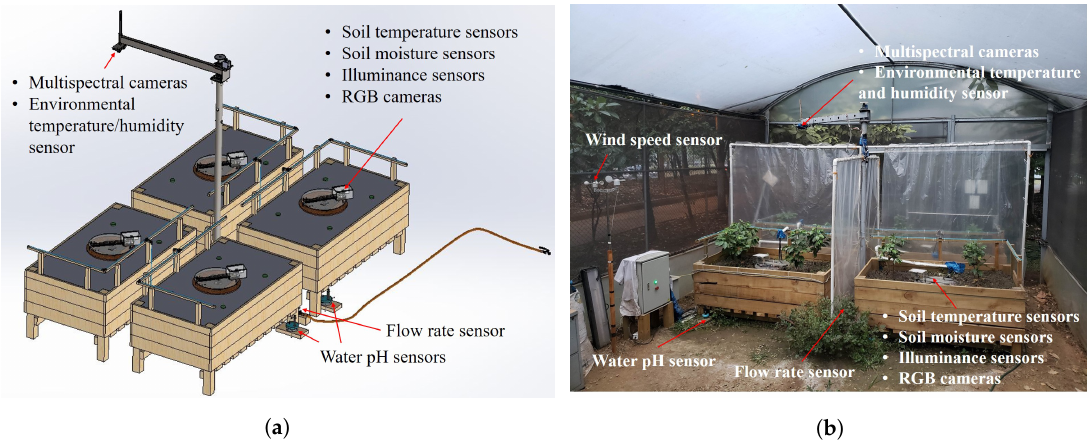
Figure 7. Experimental testbed: ( a ) 3D CAD model; ( b ) implemented prototype.